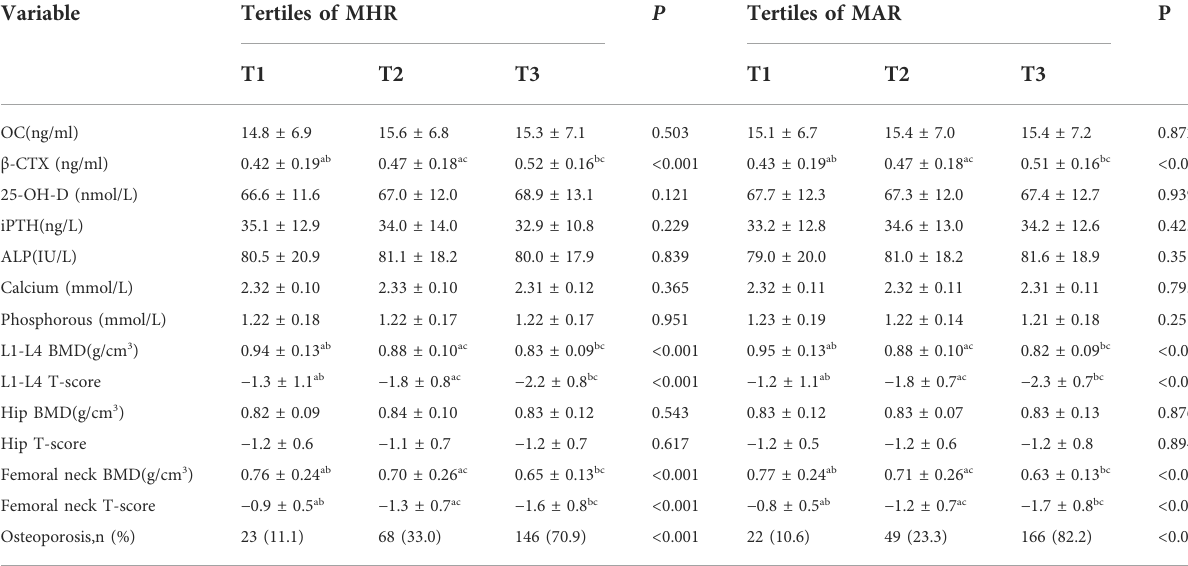
TABLE 2 Bone turnover markers and bone mineral density of participants based on tertiles of MHR (10 8 /mmol) and MAR (10 8 /g). Variable